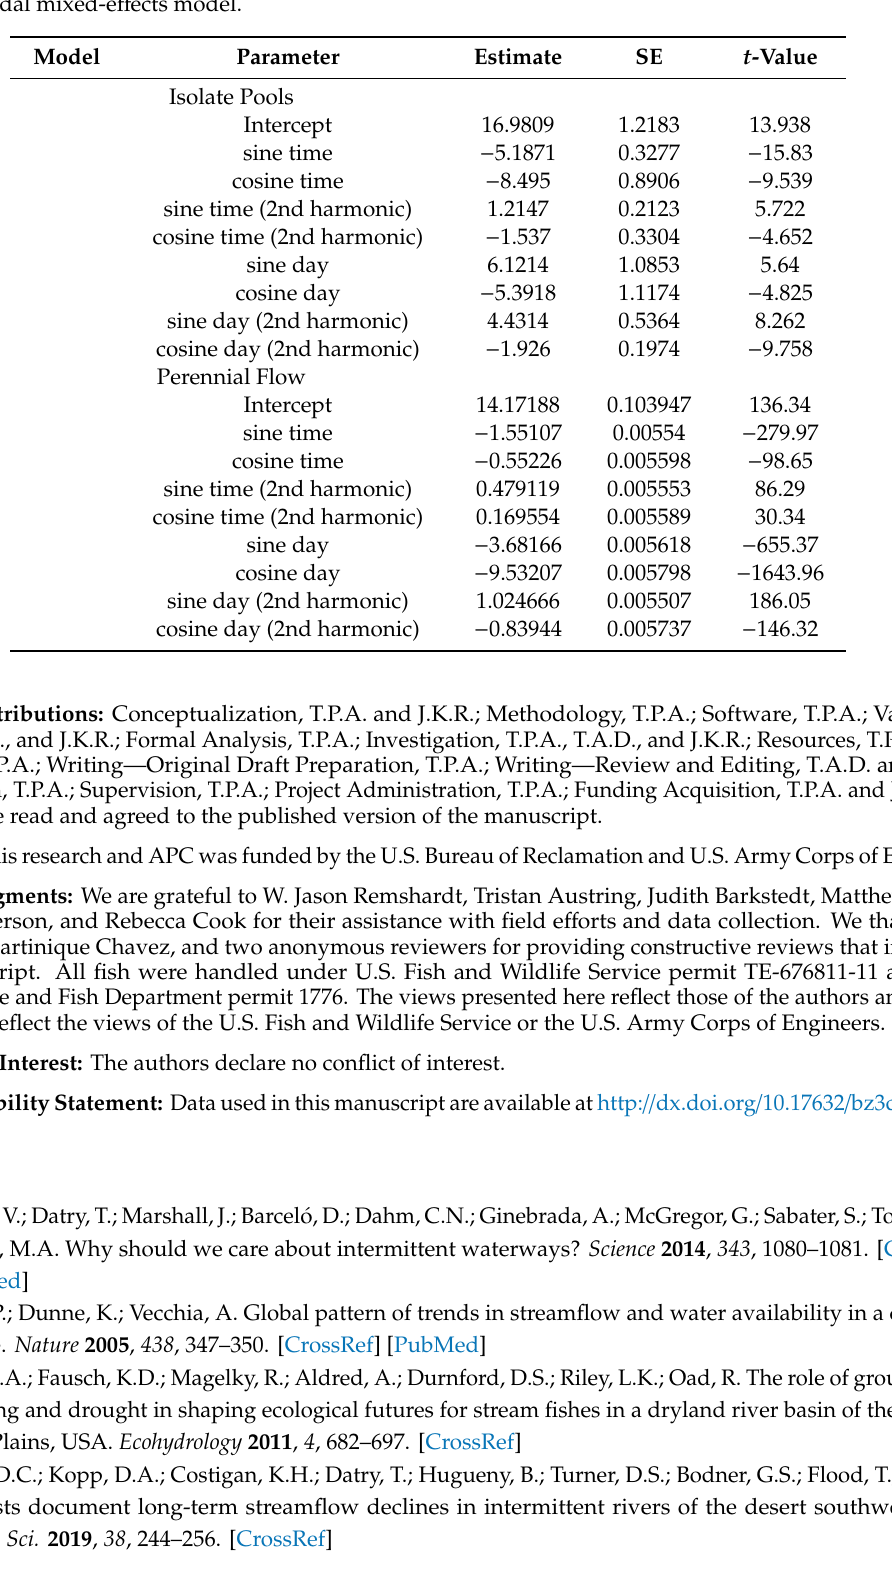
Table A1. Model parameters relating temperature of isolated pools or stream temperatures in a perennial section of the Rio Grande, New Mexico, to time of day and day of year in a linearized sinusoidal mixed-e ff ects